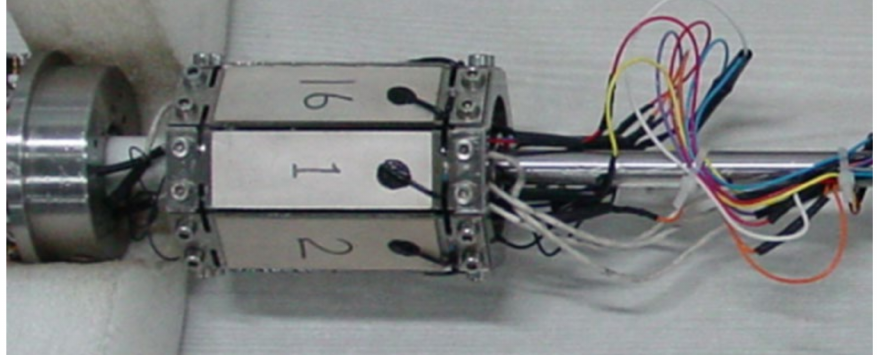
Figure 8. Physical installation diagram of the underwater acoustic response test of transmitting piezoelectric